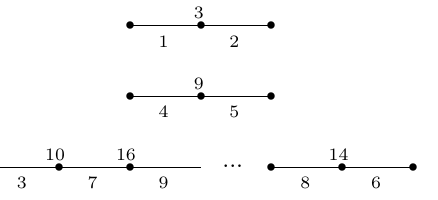
P n ( n 6) have distinct vertex sums, except for f + ( z 1 ) = f + ( u 1 ) = 3. ≥ (cid:83)